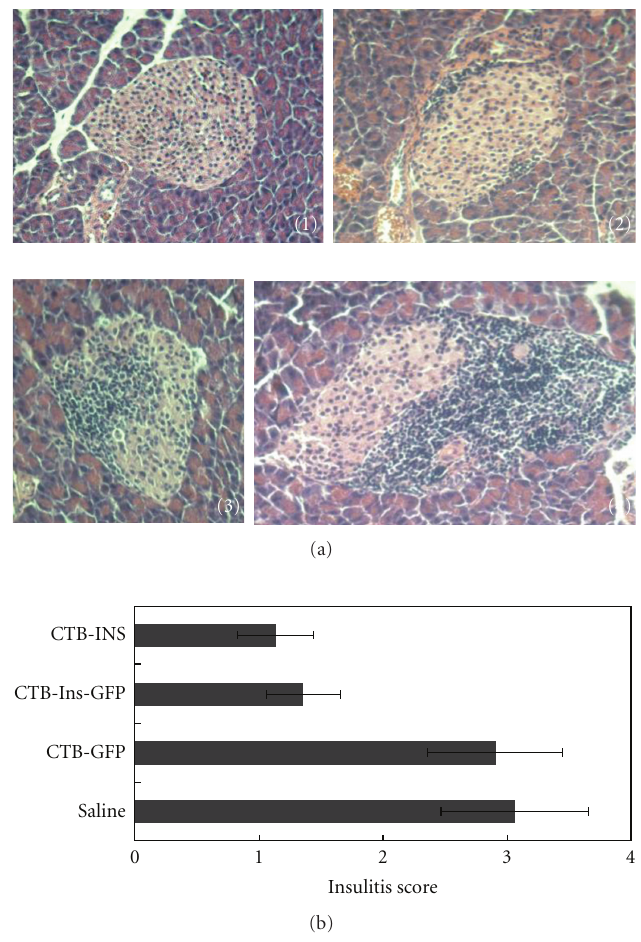
Figure 4: Insulitis score analysis. (a) Representative histopathological pancreatic islets from normal mice or experimental NOD mice. (b) Semiquantitative analysis of pancreatic islet insulitis score. Data are expressed as the mean score for each group ± SD. The ANOVA test revealed a significant reduction in insulitis in mice fed CTB-INS or CTB-Ins-GFP in contrast to the CTB-GFP or Saline group (1.1 ± 0.3 and 1.4 ± 0.3 versus 2.9 ± 0.5 and 3.1 ± 0.6, resp., P < . 05). No significant di ff erence in insulitis score was found in mice fed either CTB-GFP or Saline. Six mice per group were tested in two separate